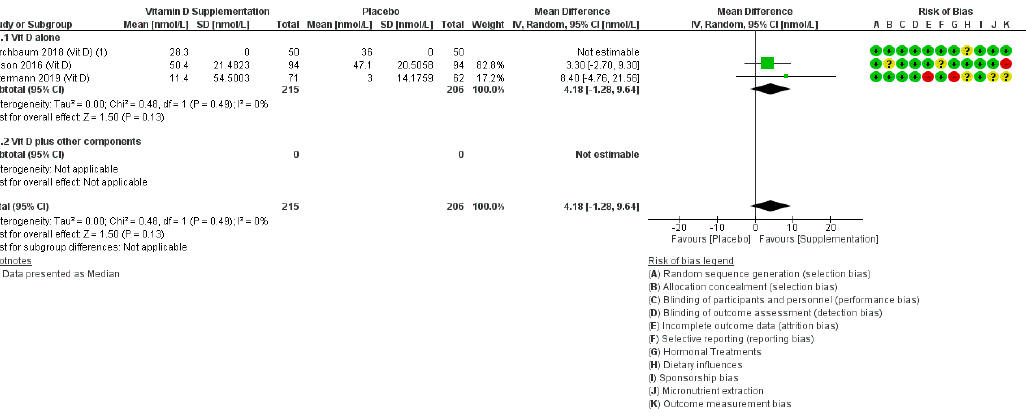
Figure 5. Forest plot showing effects of increasing vitamin D on SHBG (nmol/L). Vit D, vitamin